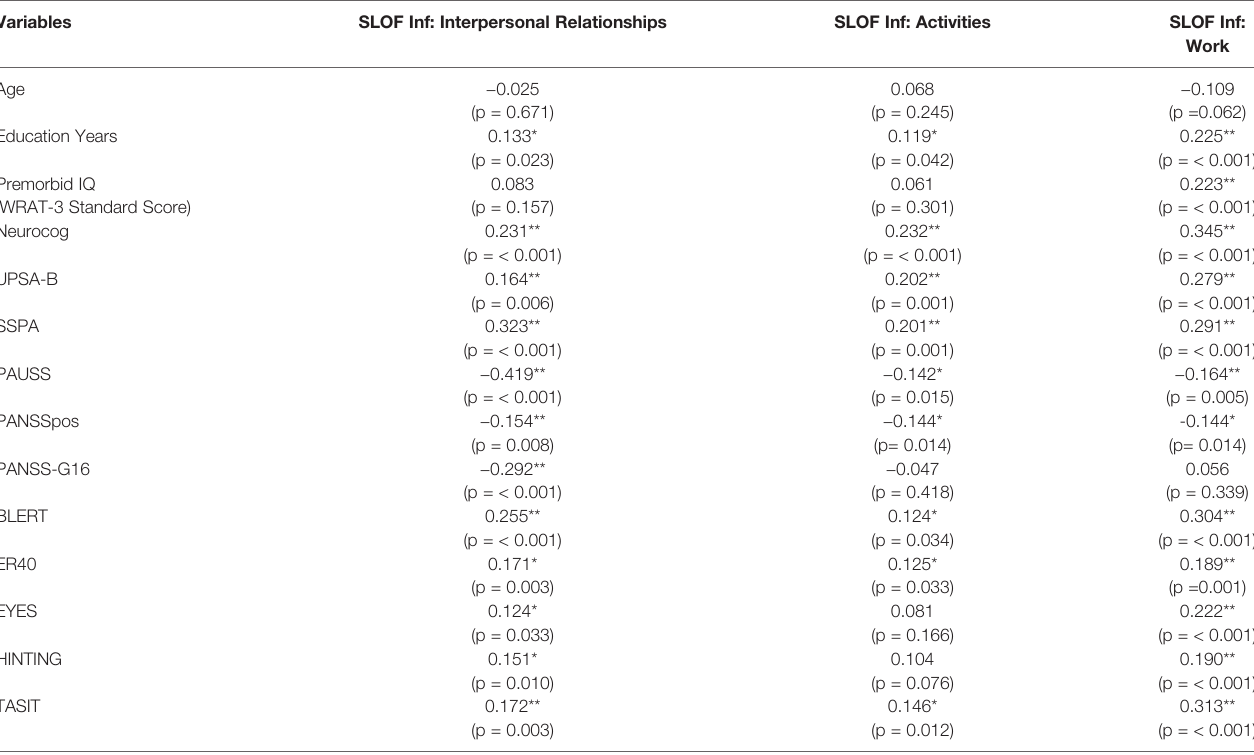
TABLE 5 | Correlations between SLOF scales and demographic, cognitive, clinical, and social cognitive variables in patients with Low PANSS-G16 (3 or lower). Variables SLOF Inf: Interpersonal Relationships SLOF Inf: Activities SLOF Inf: